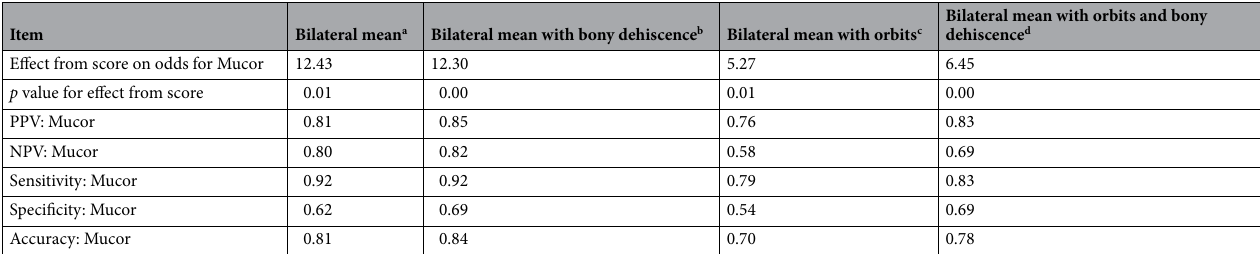
Table 2. AIFR classification of Aspergillus versus Mucor in various combinations of the bilateral mean model. a Model included nasal cavity, maxillary sinus, ethmoid air cells, sphenoid sinus and frontal sinus. b Model included nasal cavity, maxillary sinus, ethmoid air cells, sphenoid sinus, frontal sinus and bony dehiscence. c Model included nasal cavity, maxillary sinus, ethmoid air cells, sphenoid sinus, frontal sinus and orbital involvement. d Model included nasal cavity, maxillary sinus, ethmoid air cells, sphenoid sinus, frontal sinus, bony dehiscence and orbital involvement.